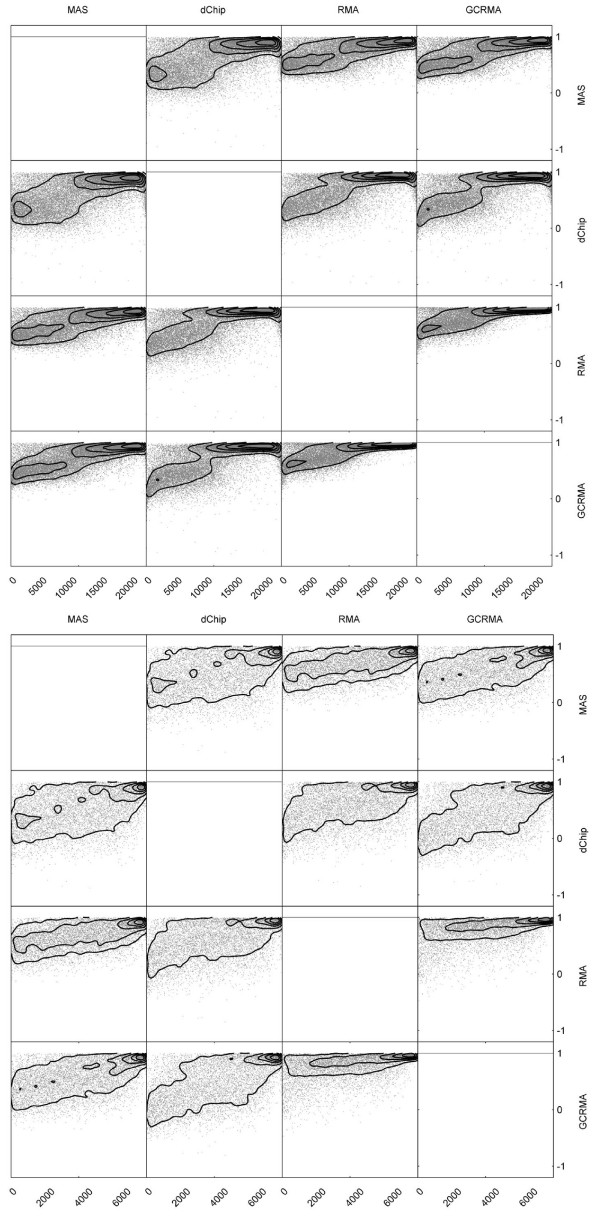
Correlation of expression values pre-processed by two methods. Pearson correlation coefficients of expression measurements calculated by two pre-processing procedures are shown on the y-axis, probe sets ranked by average expression level over the four pre-processing methods are shown on the x-axis. Contours indicate equal density, as estimated using a Gaussian kernel density estimate, with kernel width optimised by leave-one-out maximum-likelihood. A. AML dataset. B. CNS dataset.